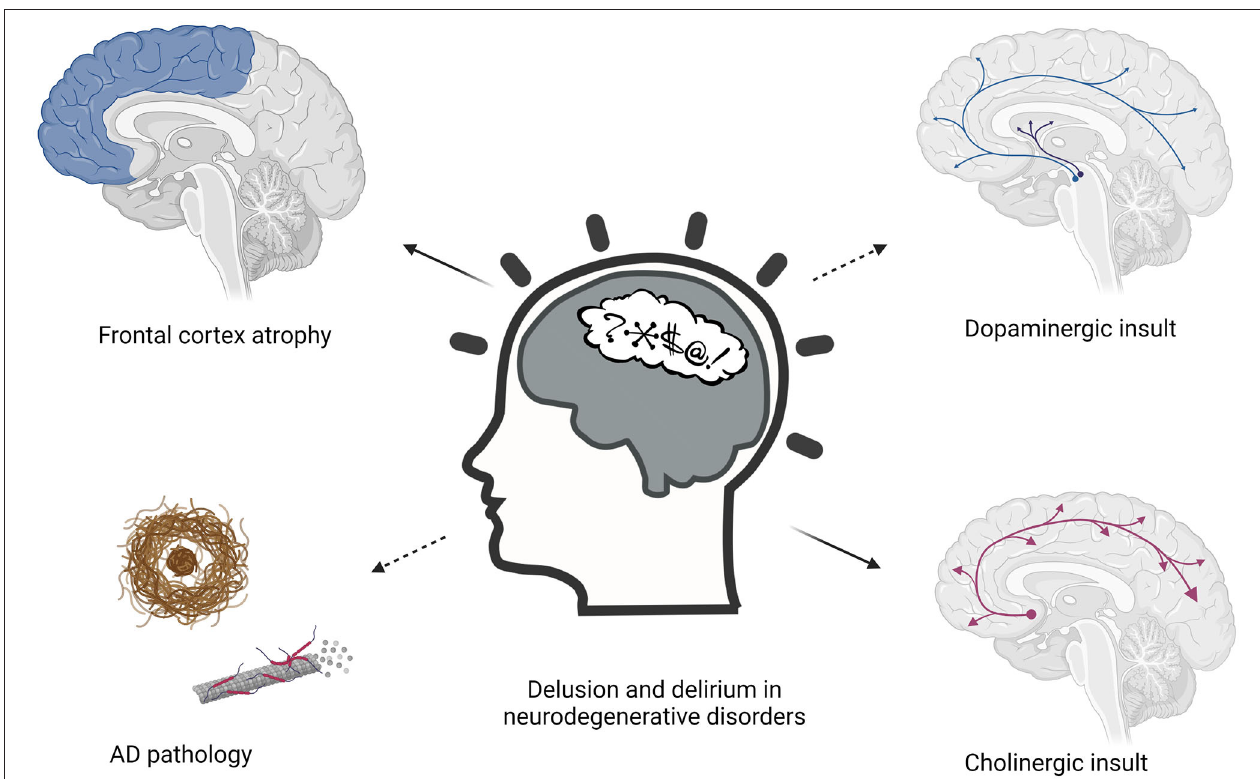
FIGURE 1 | Pathophysiological hypothesis about the etiology of delusions and delirium in neurodegenerative